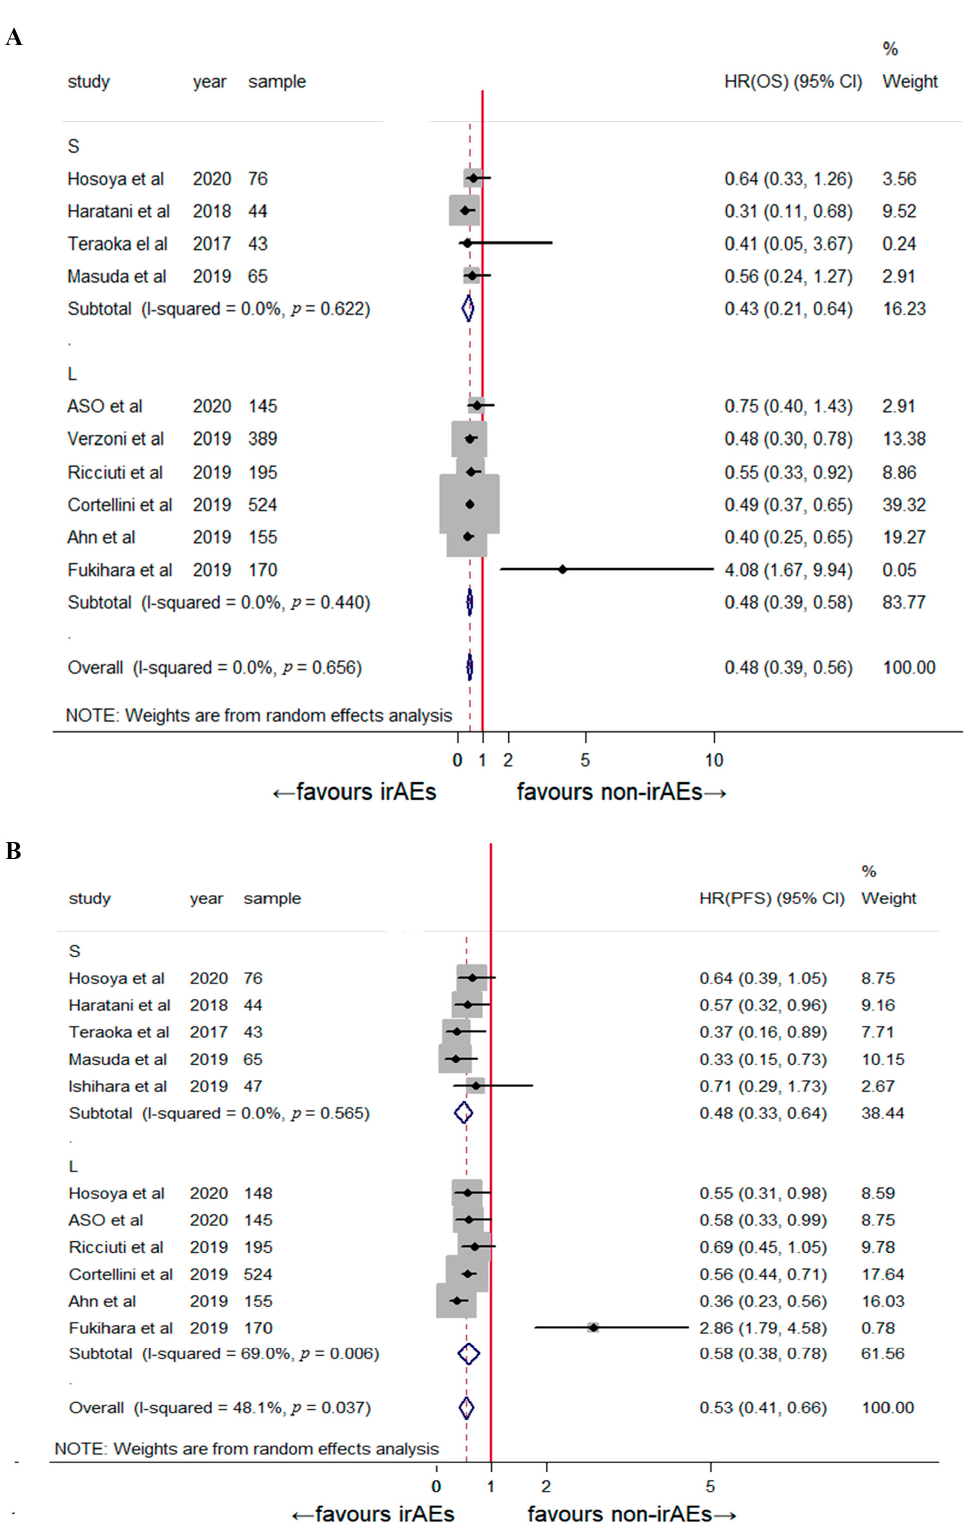
Figure 4. Subgroup analysis of the association between early-onset irAEs and ( A ) overall survival [2,8,13–17,20–22] and ( B ) progression-free survival [2,8,13–18,20,21] stratified by sample size. S indicates small; L indicates large.